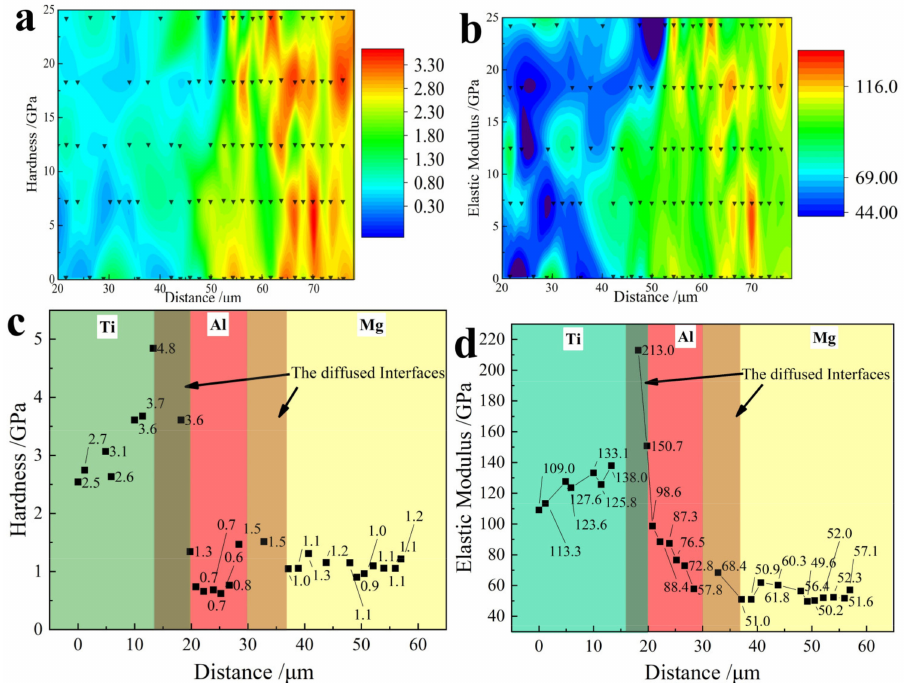
Figure 6. Indentation matrix of Mg-(Al-)Ti interfaces: ( a ) mapping of hardness; ( b ) mapping of elastic modulus, where the triangle denotes the related impresses; ( c ) hardness around the interfaces; ( d ) elastic modulus around the